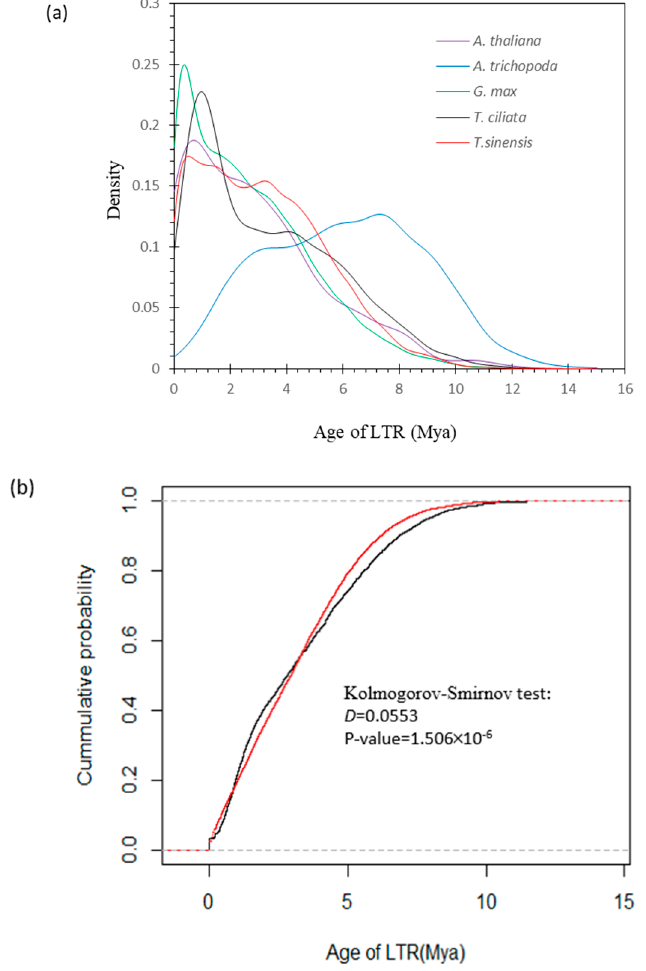
Figure 5. Evolutionary divergence in terms of LTR insertion times: ( a ) Distribution of the LTR